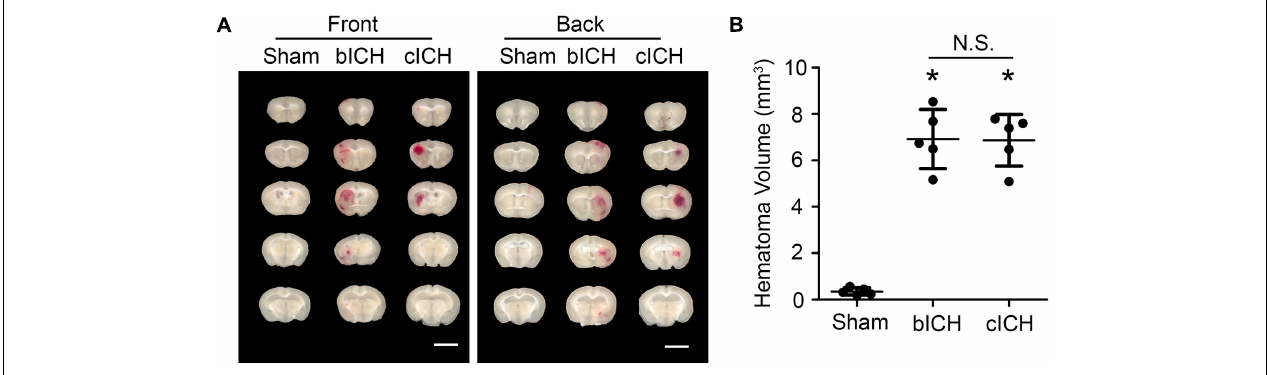
FIGURE 1 | Hematomas on day 1 after blood-induced intracerebral hemorrhage (bICH) and collagenase-induced ICH (cICH) were matched for size. Eight- to ten-week-old male C57BL/6 mice underwent collagenase injection, blood injection, or sham procedure. Mice were sacrificed at day 1 post-ICH. (A) Representative images from fresh brain coronal sections. (B) Quantification of hematoma volume. ∗ p < 0.05 vs. Sham; N.S., not significant; n = 5. Results are presented as scatter plots (mean ± SD). One-way ANOVA followed by Dunn’s multiple comparison post-test. Scale bars: 1 mm.